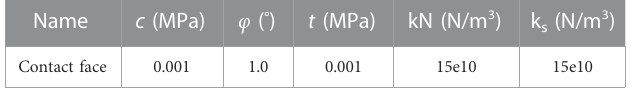
TABLE 6 Calculation parameters of the contact surface.